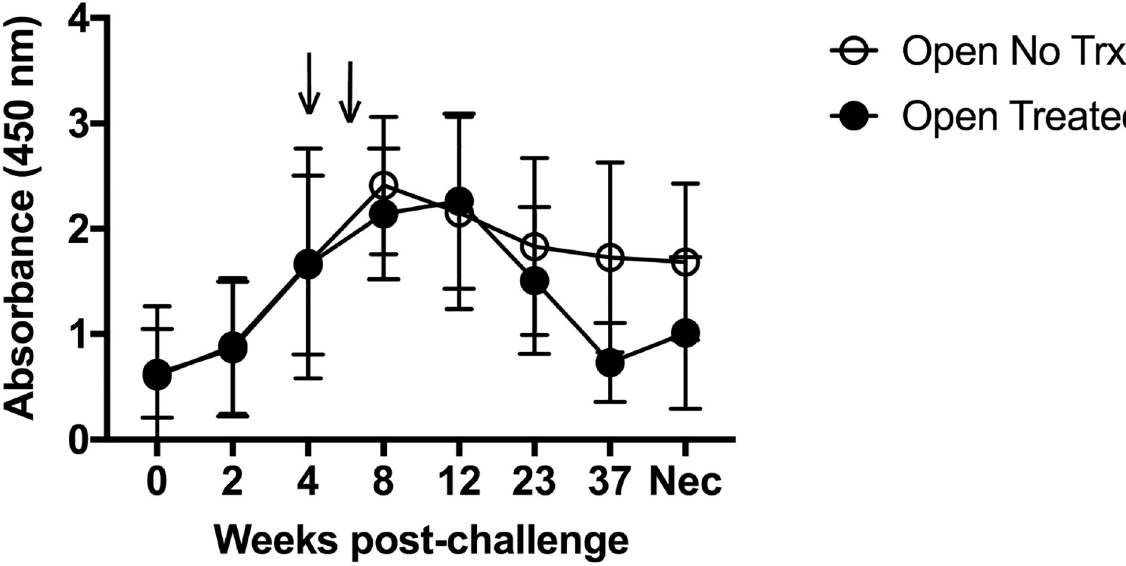
Fig 1. Assessment of antigen-specific IgG responses in serum following challenge of goats with B . melitensis 16M. Time course of B . melitensis 16M-specific total IgG in serum of goats infected with B . melitensis 16M that were either treated (black circles) or not treated (open circles) with tulathromycin. Arrows denote timing of tulathromycin administration, 4 and 6 weeks